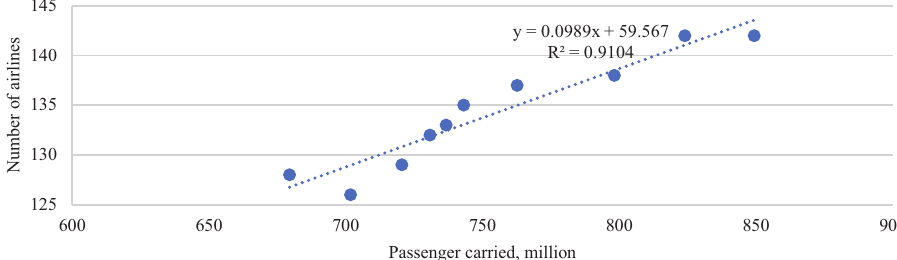
Figure 6. Regression result of passenger carried in the US from 2008 to